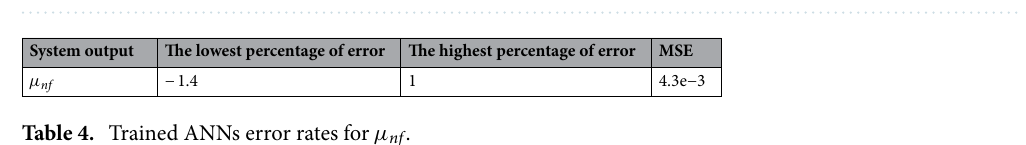
Figure 7. Regression diagram for µ nf output.